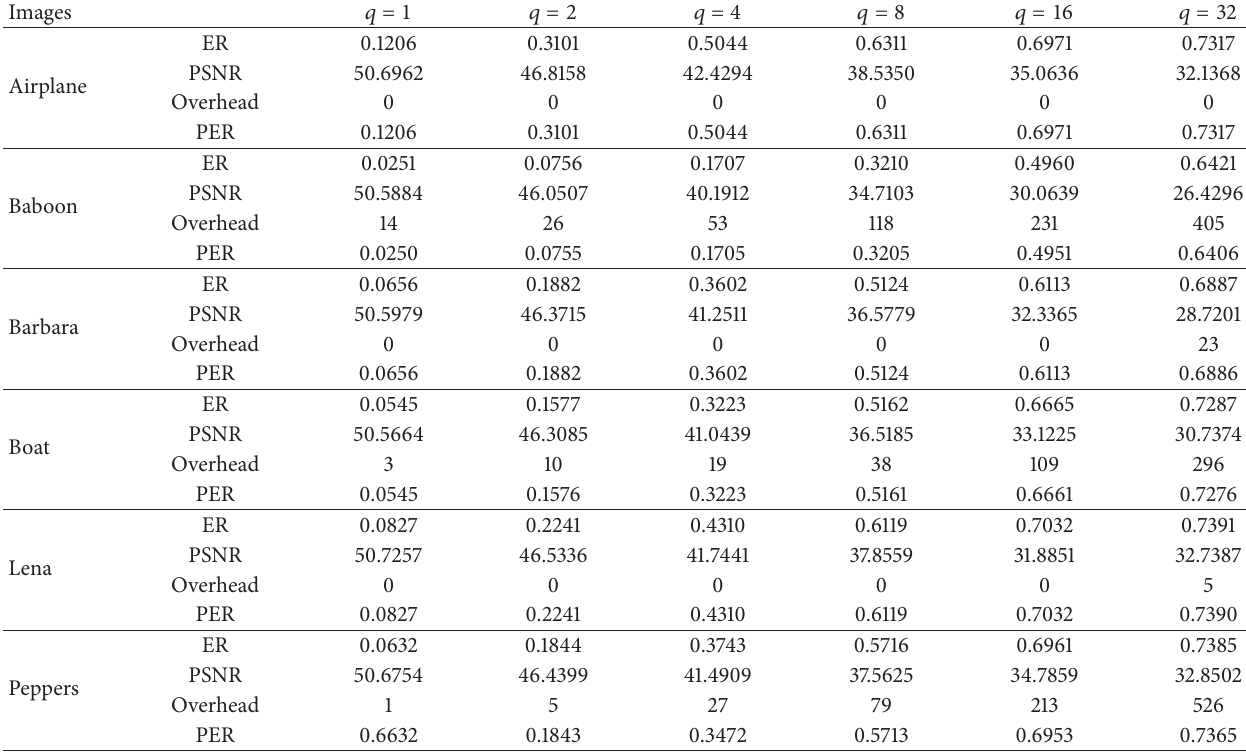
Table 2: Embedding rate and PSNR of different images (USC-SIPI).